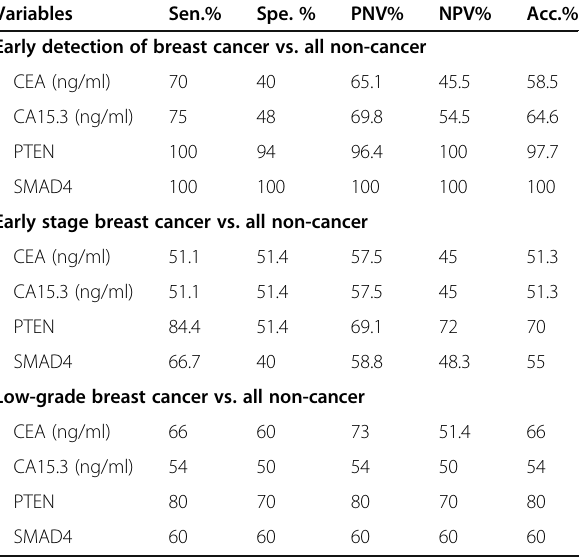
Table 3 Overall sensitivity, specificity, PPV, NPV, and accuracy of investigated methylated genes and tumor markers Variables Sen.% Spe. % PNV% NPV%